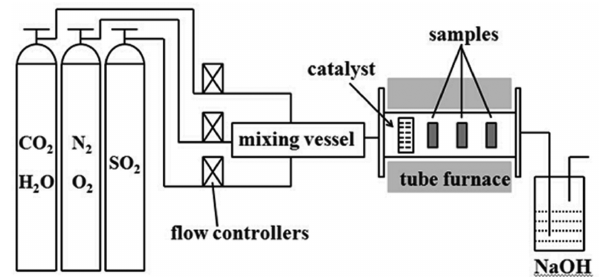
Figure 1: Setup of the